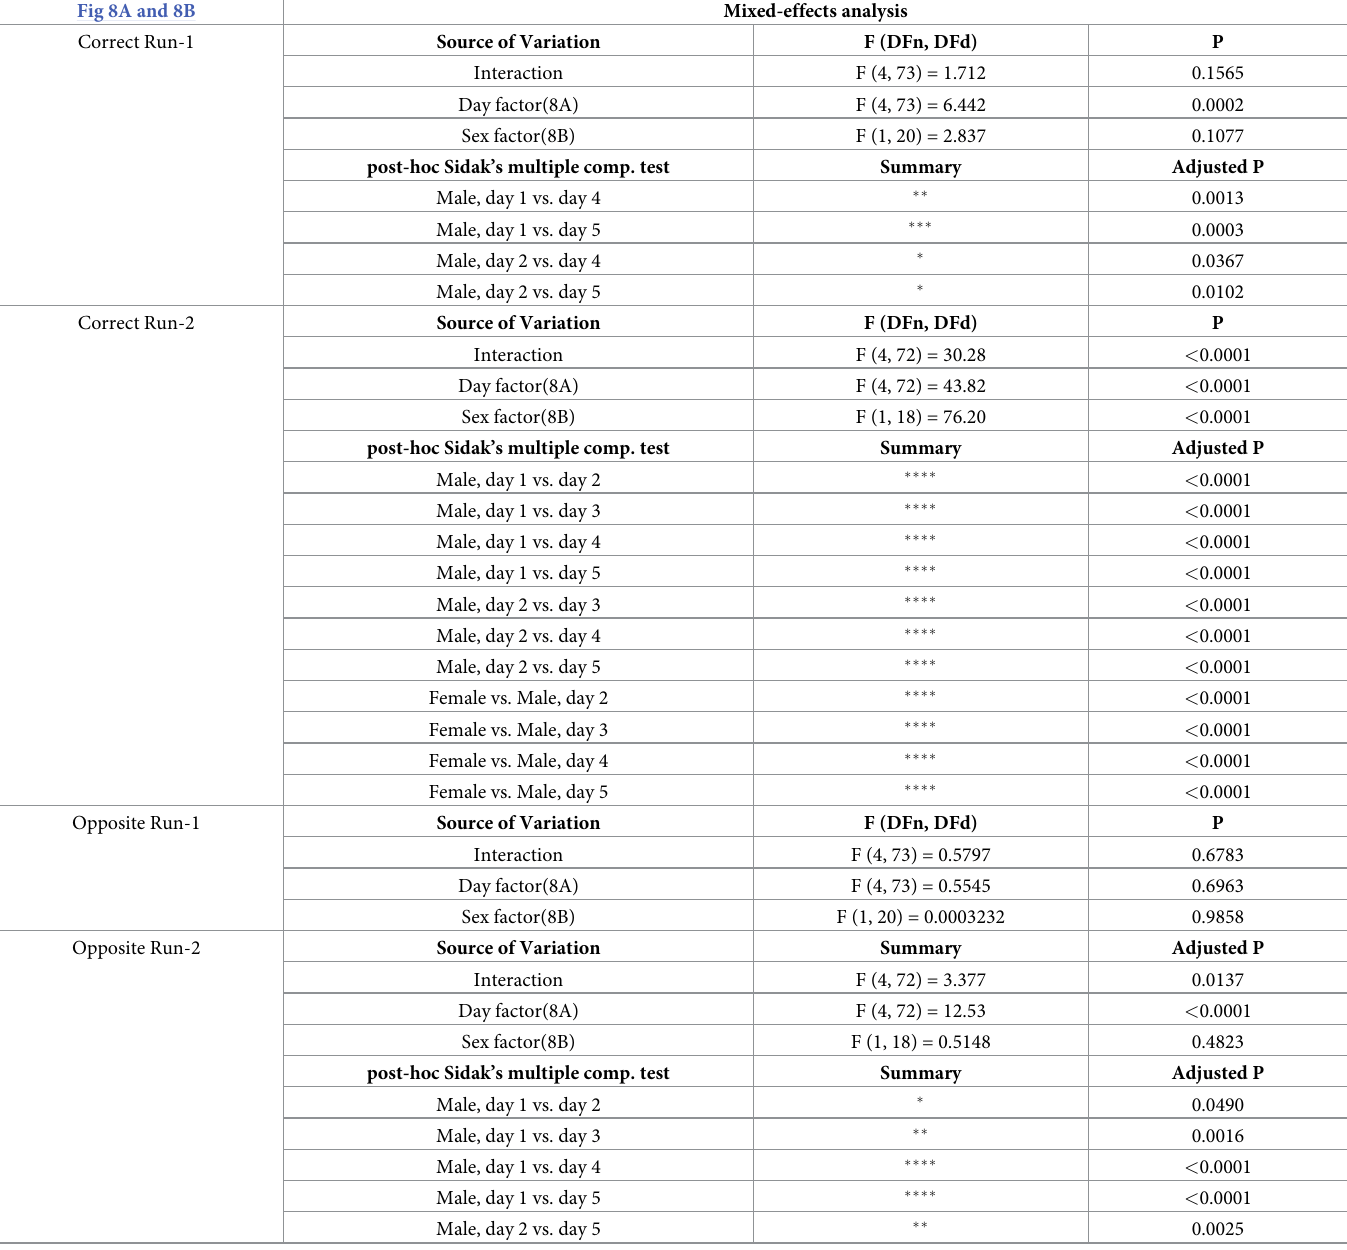
Table 12. Statistical analysis of data shown in Fig 8A and 8B for behavioral sequencing, cohort B, Run-1, and Run-2. Fig 8A and